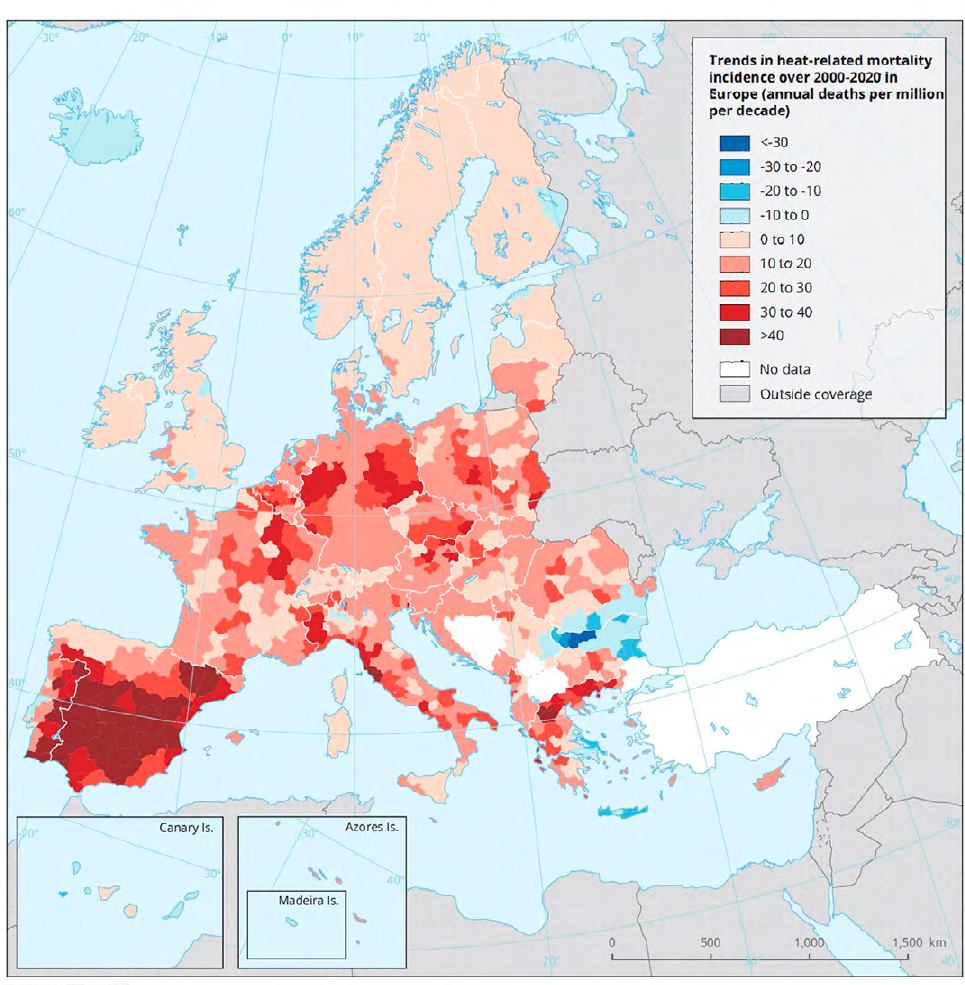
Figure 3. B) Trends in heat-related mortality incidence in the period 2000-2020 in Europe (annual deaths per million per decade). The smallest regions possible were used, depending on the spatial resolution of the mortality data in a given country, i.e., ranging from the NUTS 3 (areas with 150,000-800,000 inhabitants) to a single